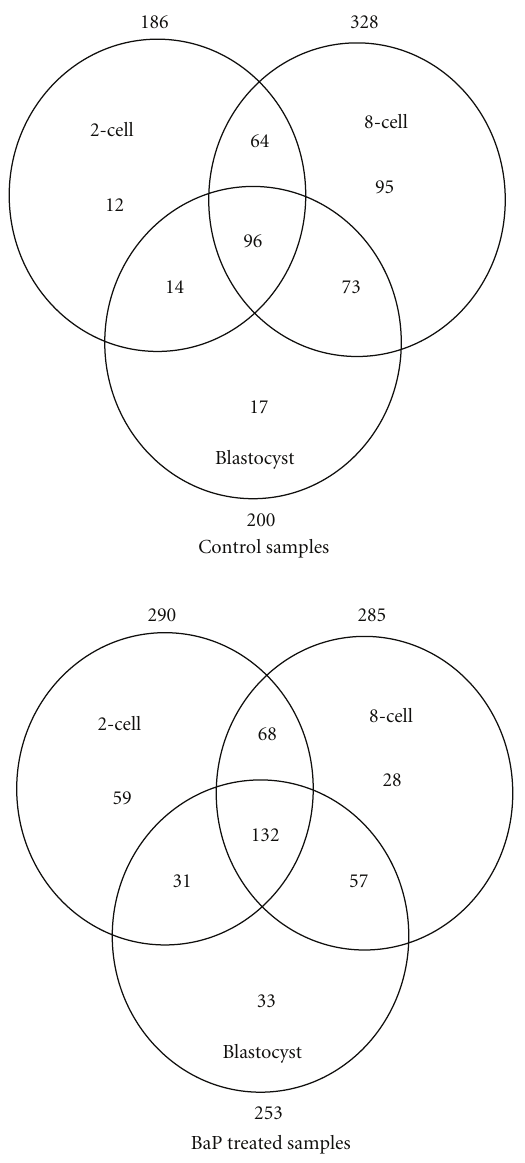
Figure 1: Venn-diagram showing number of samples at the three di ff erent developmental stages among control embryos and embryos of B[a]P exposed fathers,